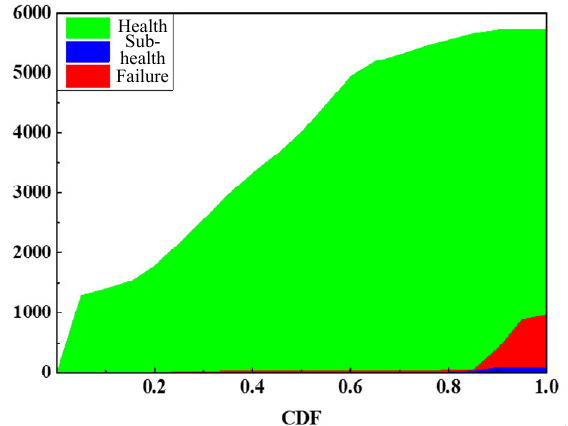
Figure 6. The overall distribution of three state data under the change of CDF.